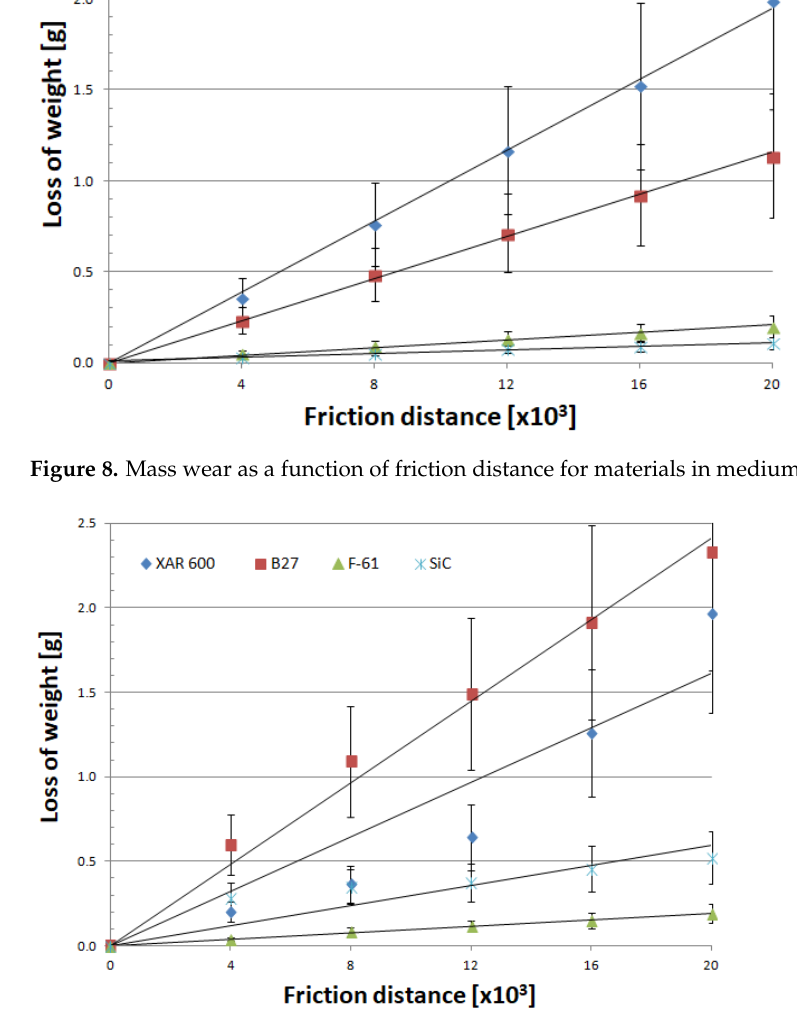
Figure 9. Mass wear as a function of friction distance for materials in heavy soil. Table 5. Mean mass wear of materials taken for the